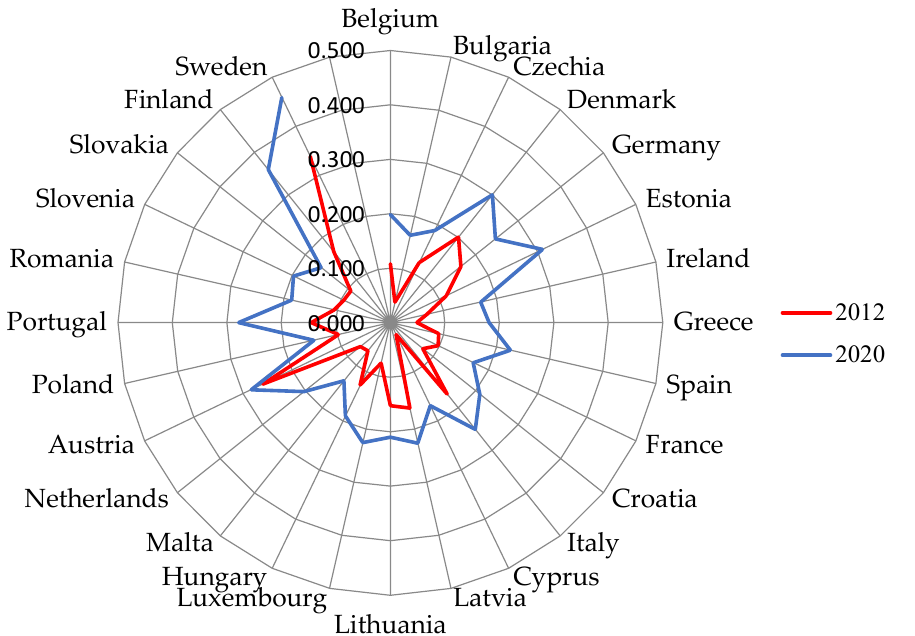
Figure 1. Distance of EU countries from the development pattern according to Hellwig’s method in 2012 and 2020. Source: own study based on data from Table